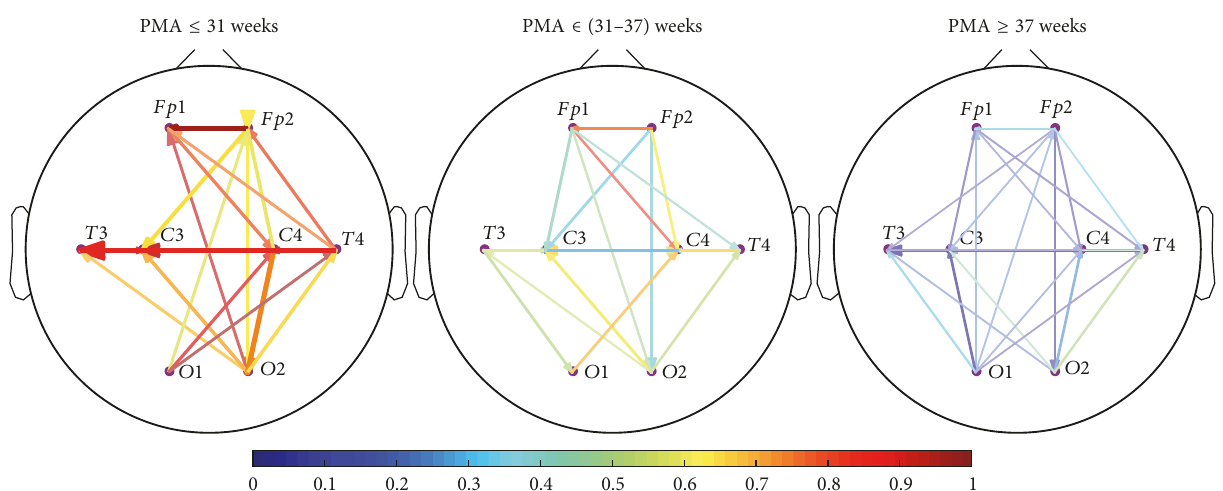
Figure 4: The figure shows the average connectivity graph (GC for three different age groups). The strength of the coupling among the electrodes is decoded by the color (the closer to the red color, the higher the coupling) and by the width of the arrow. The connectivity values have been normalized between 0 and 1 for the three groups together. The panels clearly show the weakening of the coupling among EEG channels with maturation. The consequence is the increase of path length and the decrease of the clustering coefficient (Figure 3). Table 2: The main integration and spectral features in three discrete time points. The table shows the indices for both sleep states (QS = quiet sleep, NQS = nonquiet sleep) and they were computed on the transfer entropy connectivity graph. The results are reported as median (IQR), where IQR stands for InterQuartile Range . The symbol 𝜌 stands for the Pearson correlation coefficient, while # represents a significant correlation with 𝑝 ≤ 0.01 . The values 10 −3 or 10 −2 mean the reported results are multiplied by a factor 10 −3 or 10 −2 . Network indices: transfer entropy in three age